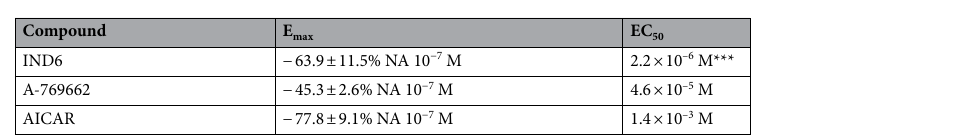
Table 2. Efficacy (E max ) and potency (EC 50 ) of IND6 , A-769662 and AICAR as vasodilators in rat aorta measured with organ bath vascular function. ***p-value < 0.001 vs. AICAR; n = 6 rats.